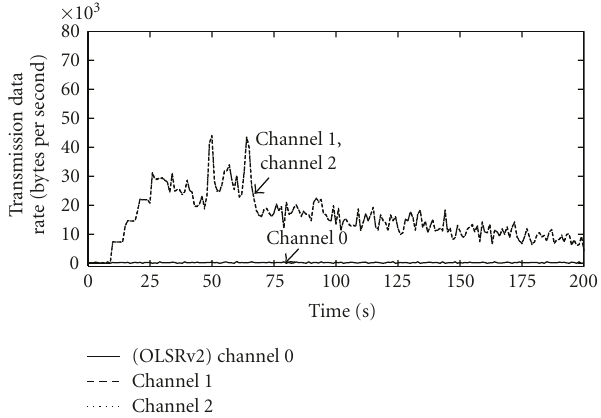
data rate at source node S, intermediate nodes A and B, respectively. In Figure 16, lines for the data transmission rate on channels 1 and 2 overlap with each other. This implies that the node S, that is, source node, evenly distributed real-time packets among these two real-time channels by observing the channel usage. The nodes A and B, that